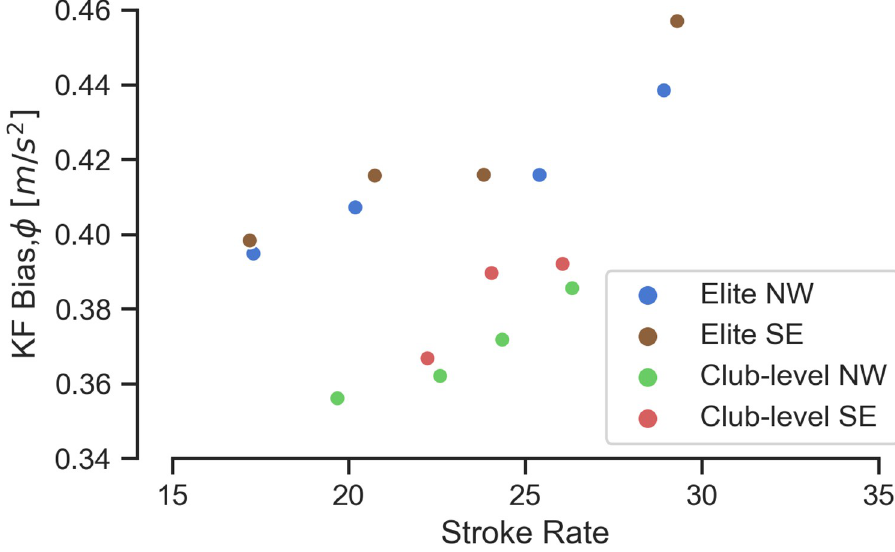
Fig 10. Terminal values of the Kalman filter bias state ϕ k for each trial. Each dot represents a single trial at the mean stroke rate. The bias is dependent on the rower/boat combination and boat